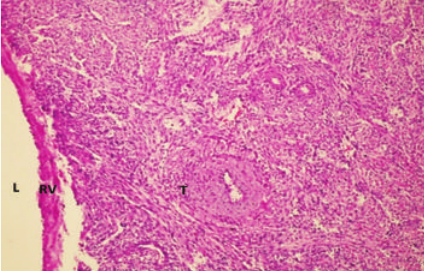
Figure 5: Diffuse SMA positivity in tumour cells (SMA ×